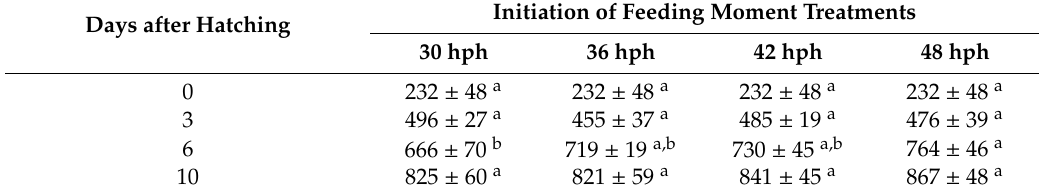
Table 2. Mouth opening gape ( µ m) of P. hypophthalmus larvae at four developmental time points following di ff erent initiation of feeding moment.